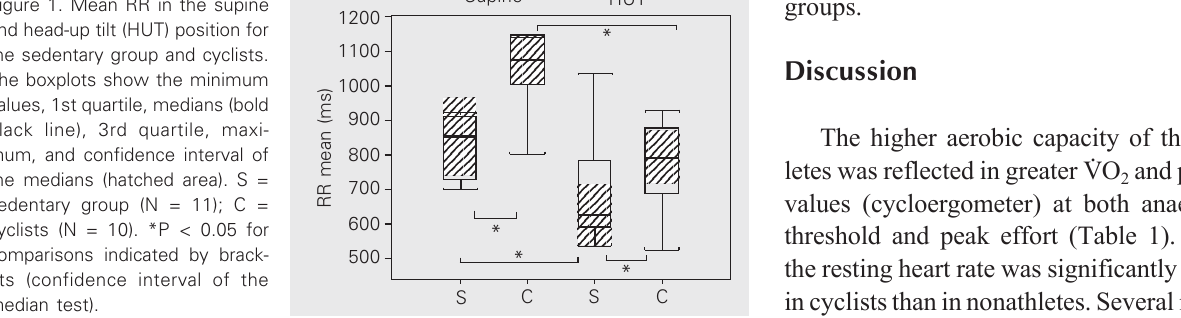
Figure 1. Mean RR in the supine and head-up tilt (HUT) position for the sedentary group and cyclists. The boxplots show the minimum values, 1st quartile, medians (bold black line), 3rd quartile, maxi- mum, and confidence interval of the medians (hatched area). S